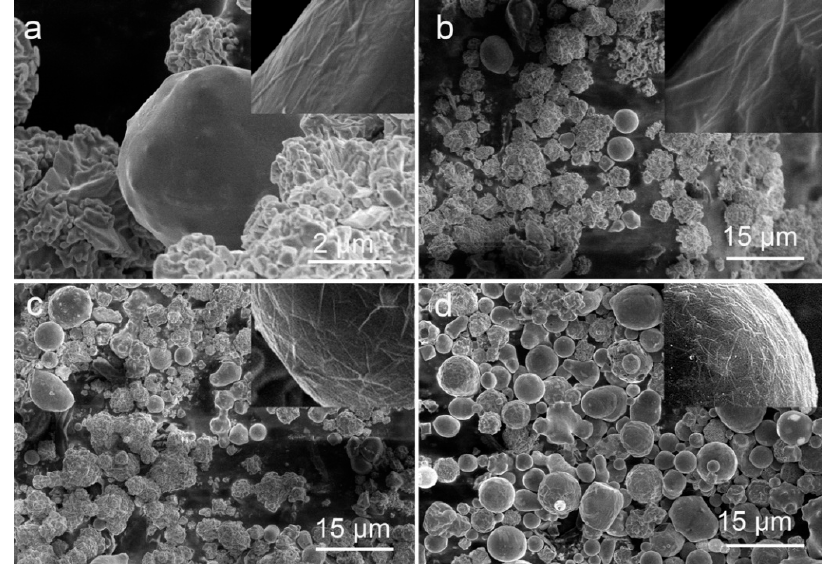
Figure 2. SEM images of Ni powder samples irradiated for different times at laser energy of 20.2 J/pulse. ( a ) One pulse, ( b ) 2 min, ( c ) 10 min, ( d ) 30 min. The inserts in panels ( a – d ) show high magnification SEM images of carbon layer on the particles.